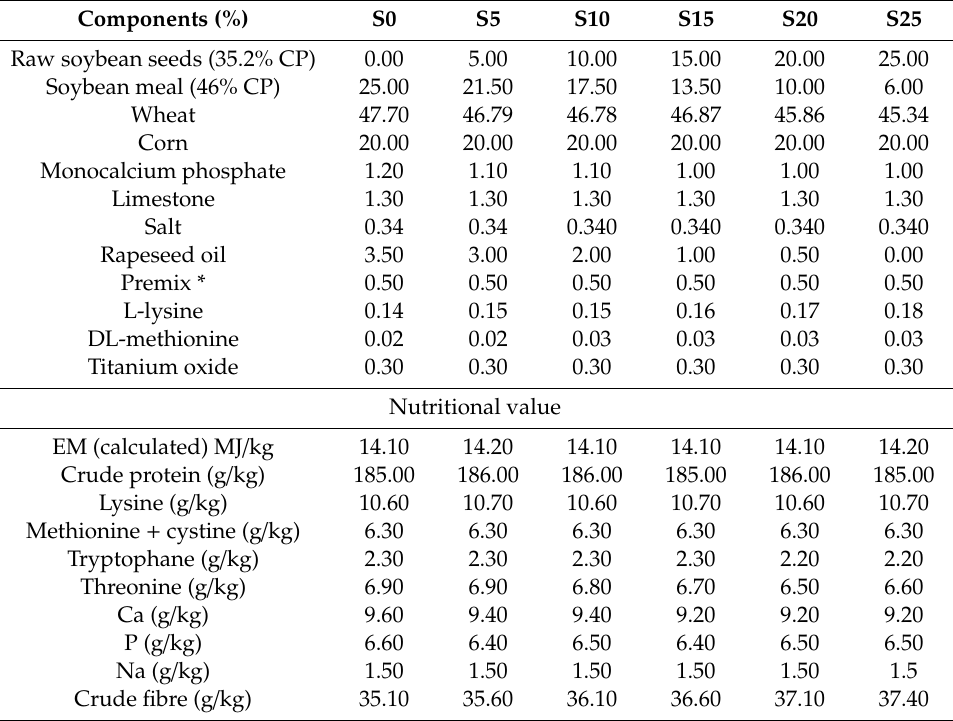
Table 1. Composition and nutritional value of feed